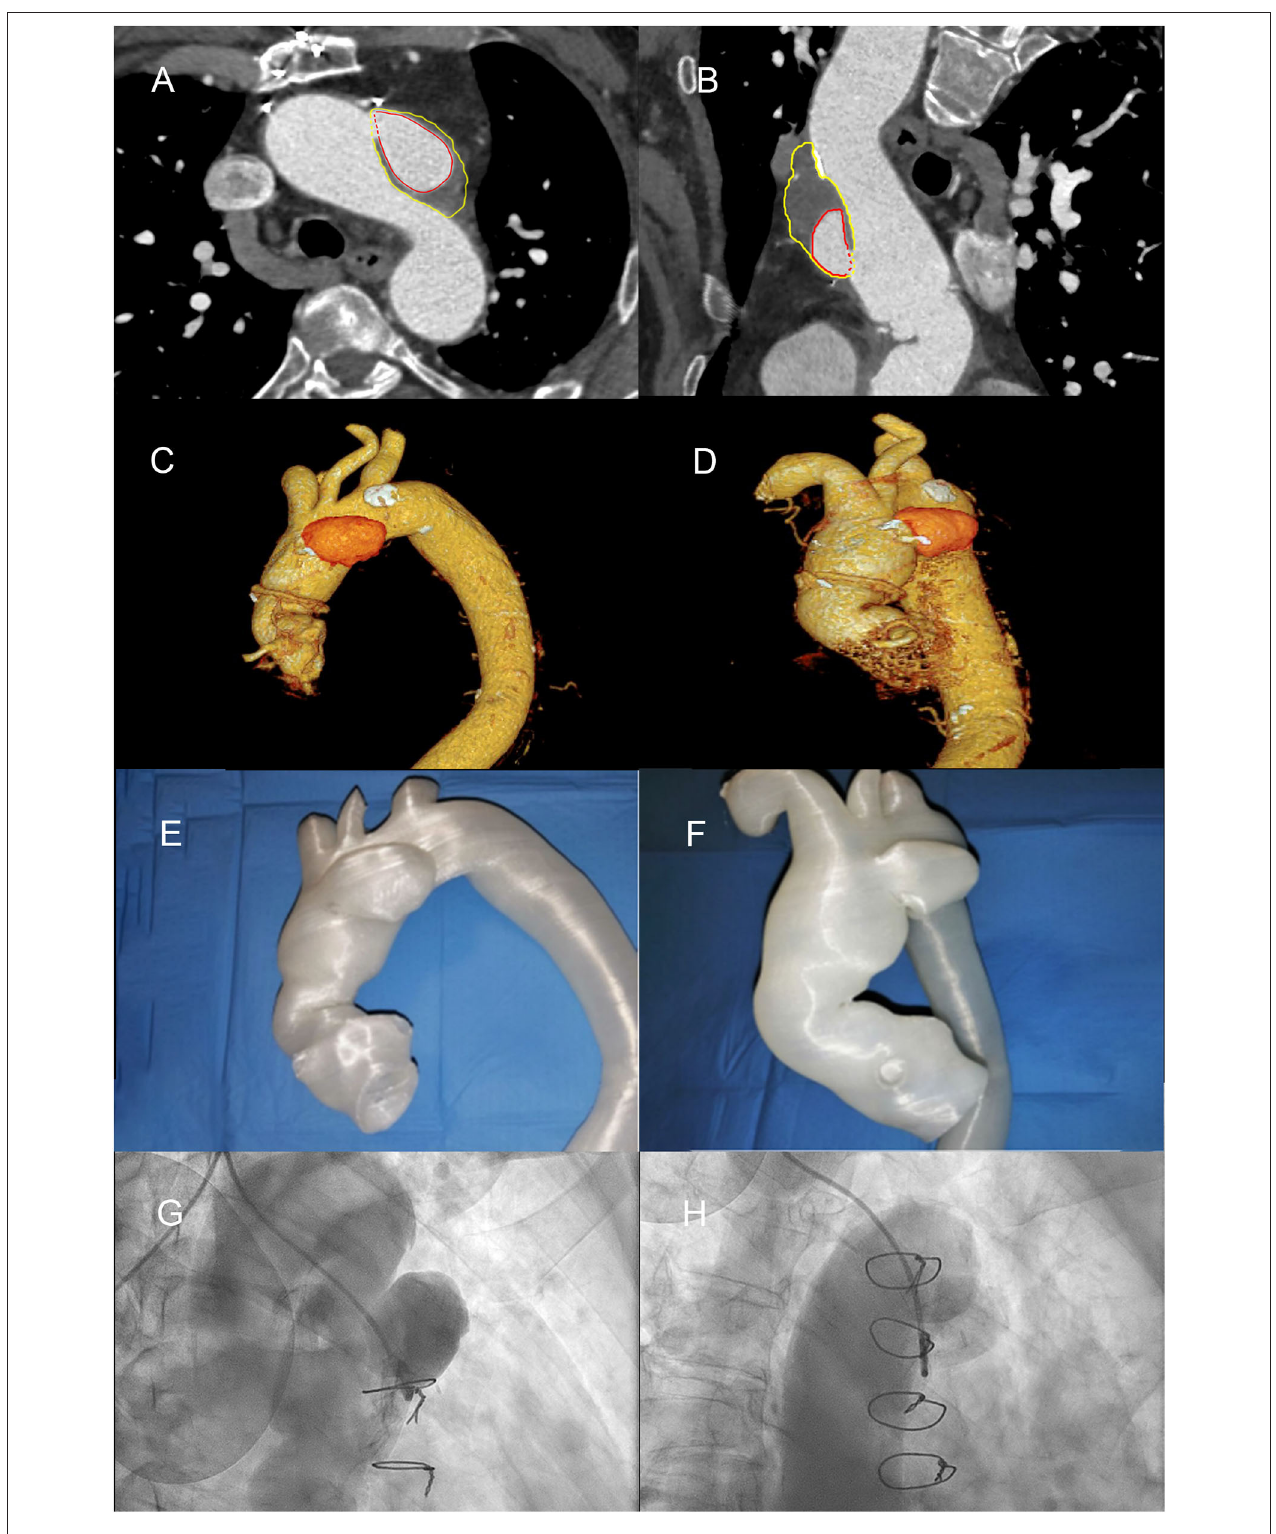
FIGURE 2 | Diagnostic angiography, computed tomography scans, and 3D printed thoracic aorta model, demonstrating aortic root, and aortic arch pseudoaneurysm (AAP). (A) Computed tomography (CT) angio-study, axial image, showing pre-treatment of AAP. The red line highlights the perfused part of the AAP; the yellow line highlights the thrombosed part. (B) CT angio-study, curved multiplanar reconstruction (MPR) of AAP. (C,D) Volume rendering (VR) reconstructions of ascending aorta. (E,F) 3D print of the thoracic aorta and AAP. (G) Right anterior oblique (RAO) cranial angiographic image of AAP. (H) RAO caudal angiographic image of AAP.